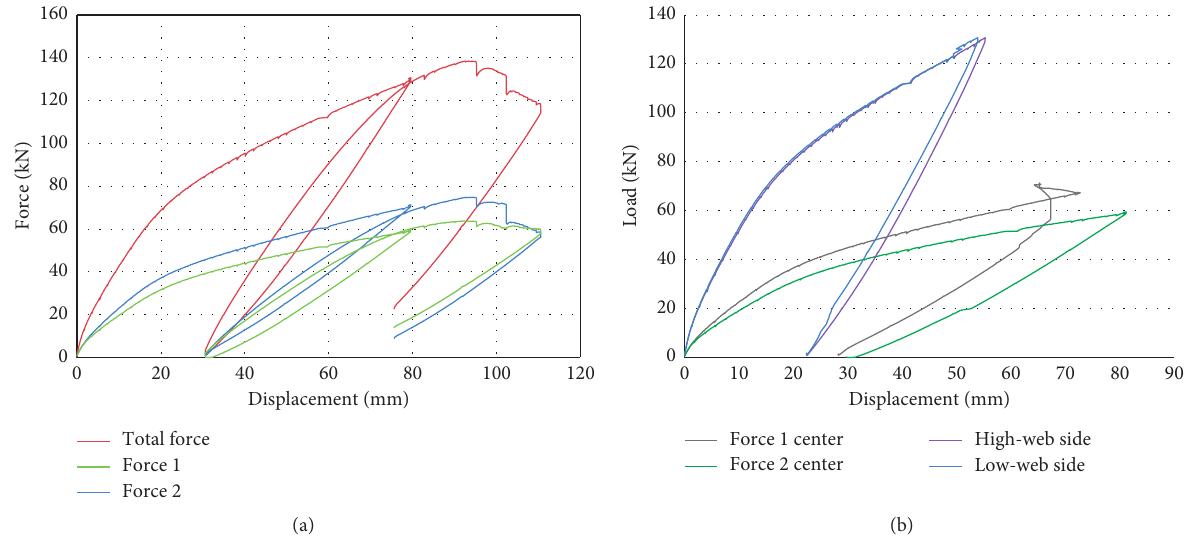
Figure 8: Load-displacement curves. (a) Member center displacement. (b) Rib and loading center